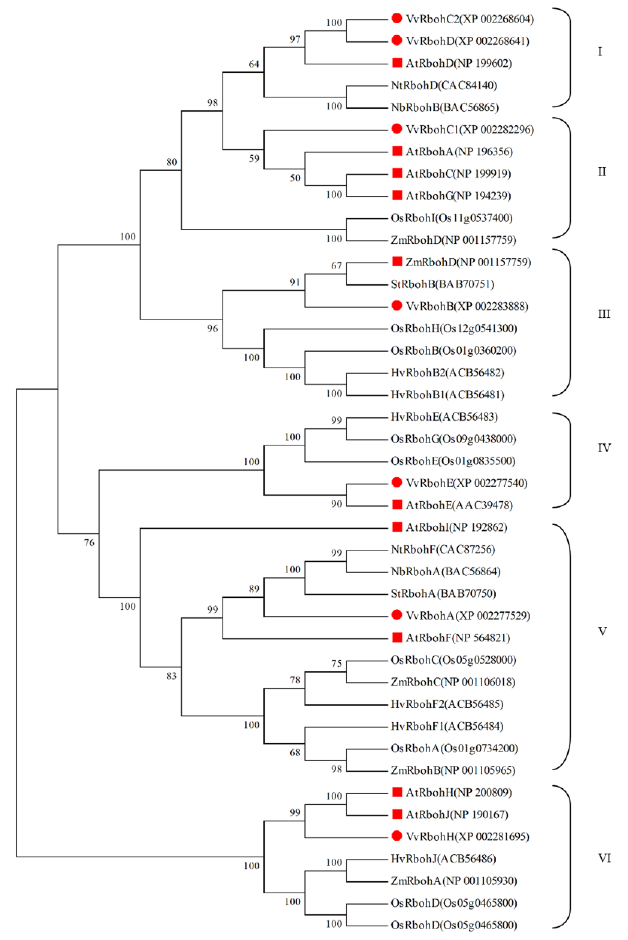
Figure 2. Phylogenetic analysis of grape and other plant Rboh proteins. The phylogenetic tree was constructed with Rboh domain protein sequences from V. vinifera (VvRboh), N. tabacum (NtRboh), Z. mays (ZmRboh), O. sativa (OsRboh), A. thaliana (AtRboh), S. tuberosum (StRboh), N. benthamiana (NbRboh) and H. vulgare (HvRboh). They were classified to six groups: I, II, III, IV, V, VI. VvRboh proteins are indicated with red circles and AtRboh proteins with red boxes. All accession numbers or locus IDs of the rboh genes are listed in the phylogenetic tree.